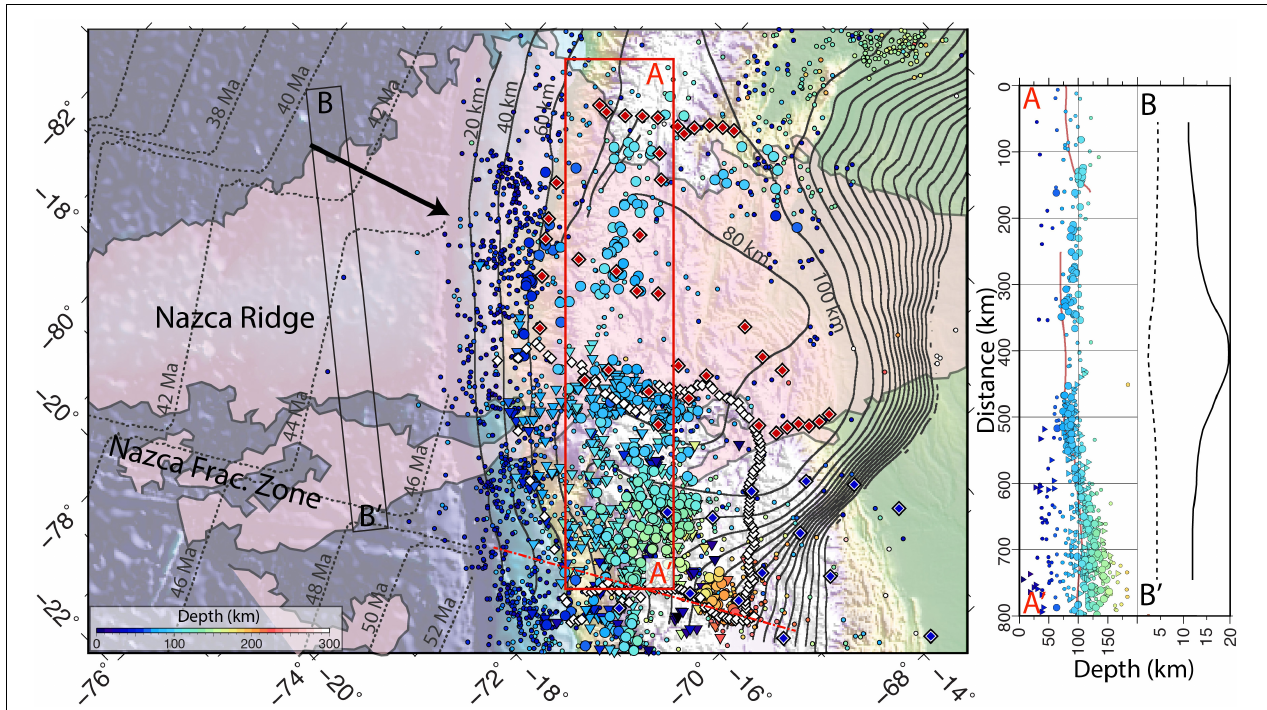
FIGURE 1 | Nazca Ridge subduction and earthquake distribution. Left: Map showing seismicity from the Reviewed International Seismological Center’s earthquake catalog (1990–2017) – small circles. Large circles are hypocenters from Kumar et al. (2016), and inverted triangles are hypocenters from Lim et al. (2018). Offshore dashed lines show oceanic plate age contours from Mueller et al. (2008). Bold arrow shows convergence direction from DeMets et al. (2010). Pink shaded region shows the outline of the projected conjugate Tuamotu Ridge from Hampel (2002). Red diamonds, blue diamonds, and white diamonds show seismic station locations for the PULSE, CAUGHT, and PERUSE experiments, respectively. Dash-dot red line shows inland projected location of Nazca Fracture Zone. Solid black lines show slab contours from Wagner and Okal (2019). Red rectangular box shows area over which events were projected onto cross section to the right. Black rectangular box shows region over which oceanic Moho topography was compiled by Contreras-Reyes et al., 2019. Right: Cross-section across the projected location of the subducted Nazca Ridge. Symbols same as to the left. Panel A,A (cid:48) cross section showing event depths (in km) for events projected from area in red box on map. Red line indicates the slab surface from Antonijevic et al. (2015) and Wagner and Okal (2019). Right panel (B,B (cid:48) ) shows depth below sea level in km for the oceanic Moho (solid black line) and bathymetry (dotted line) across the Nazca Ridge from Contreras-Reyes et al.